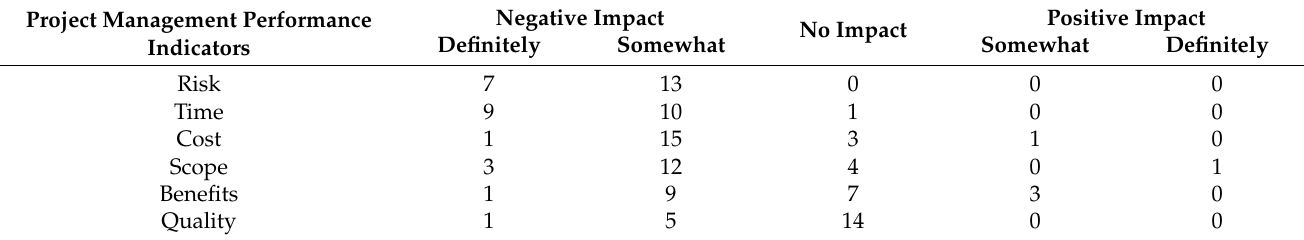
Table 1. The assessment of the COVID-19 pandemic’s impact on individual dimensions of effectiveness of imple- mented